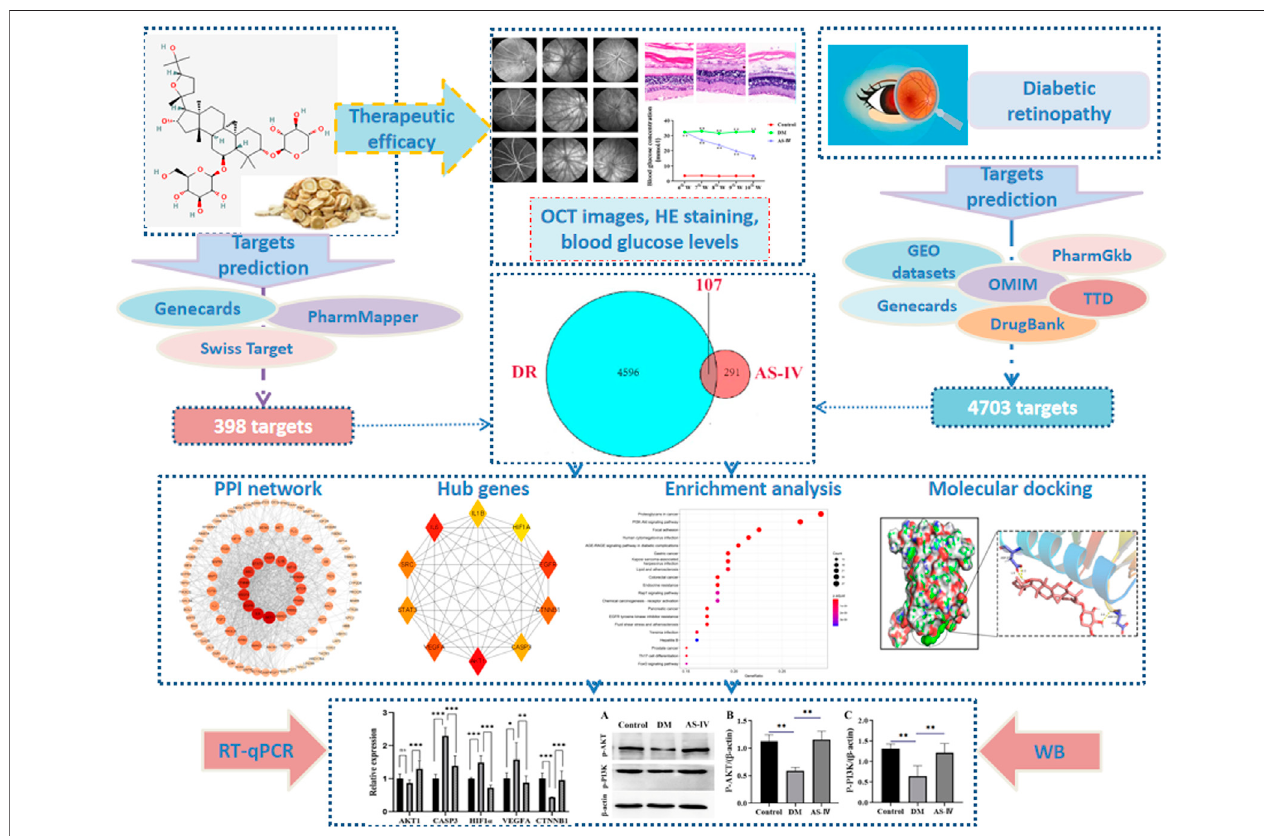
FIGURE 1 | Flow chart of study design. DR, diabetic retinopathy; AS-IV, astragaloside IV; RT-qPCR, real time quantitative polymerase chains reaction; WB, western blot.